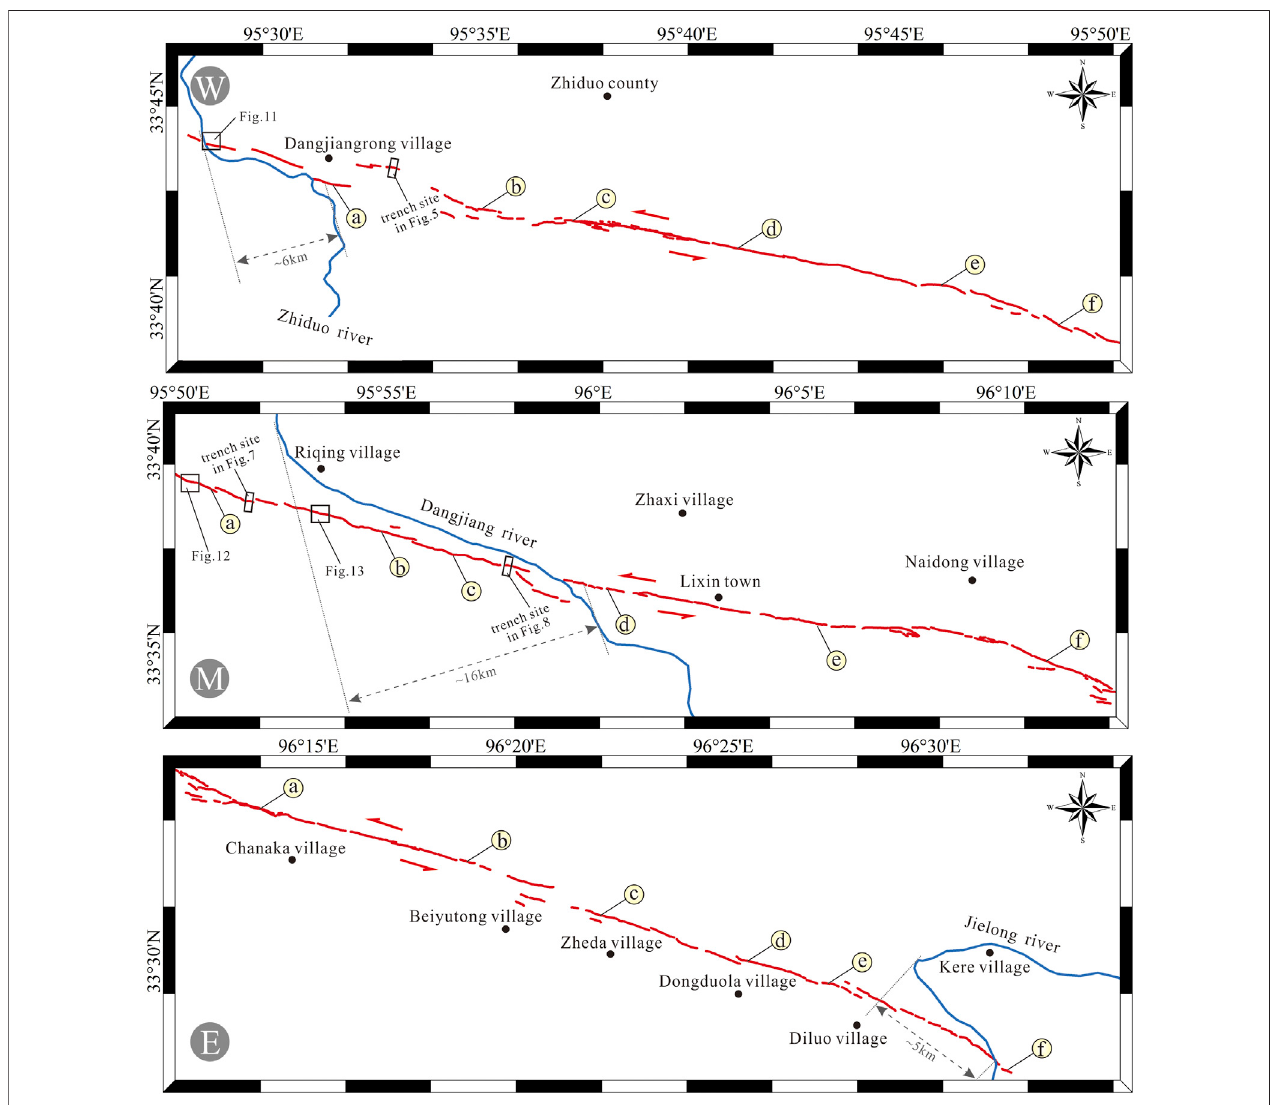
FIGURE 3 | Fine fault geometries interpreted based on high-resolution satellite images and fi eld observations. The red lines represent the co-seismic surface rupture traces of the CE 1738 Dangjiang historical earthquake. The blue solid lines represent the regional de fl ected rivers. The capital letters of W, M, and E in the map representthewestern,middle,andeasternsectionsoftheDJF,respectively,andthemarksfrom(a,b,c – f)tocorrespondtothelocationsofthephotographsin Figure4 , Figure 6 , and Figure 9 , respectively.